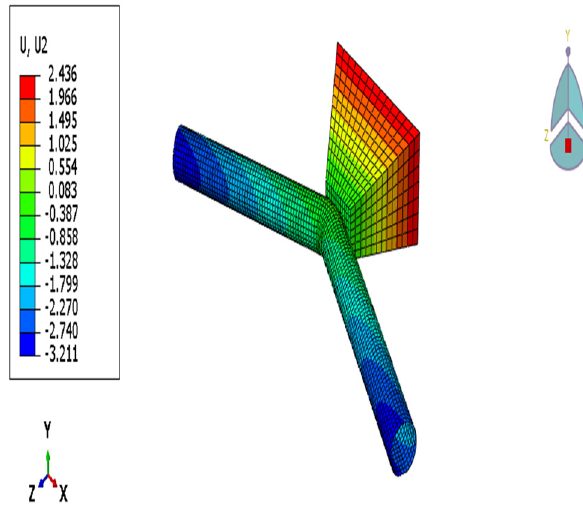
Figure 9: Vertical displacement of thrust block ( mm ) .